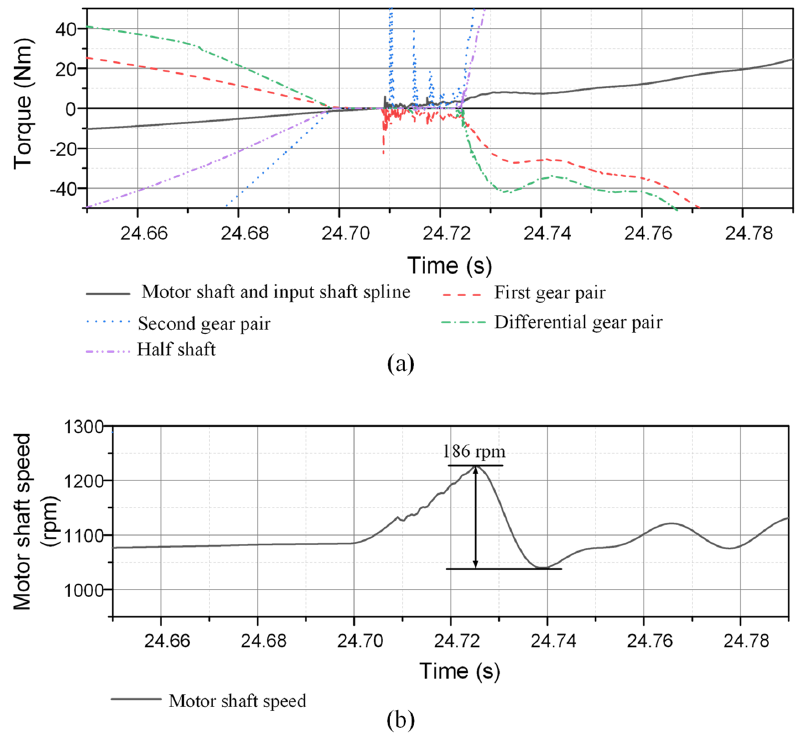
Figure 7. Responses of the torques and speed with the motor torque were halved. ( a ) Torque curves corresponding to the first and second-level meshing pairs. ( b ) Motor shaft speed).